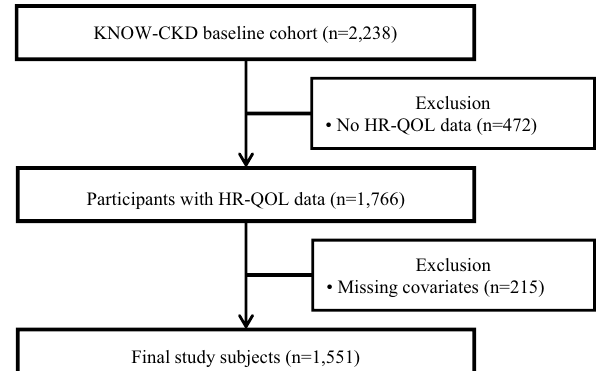
Figure 1. Algorithm for study patient selection from the KNOW-CKD cohort. HR-QOL, health-related quality of